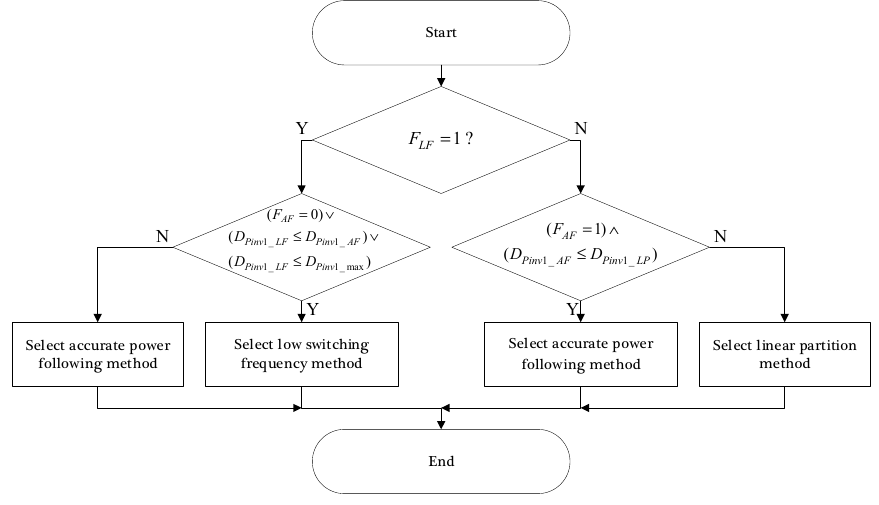
Figure 9. Flowchart of the voltage vector distribution method selection strategy.